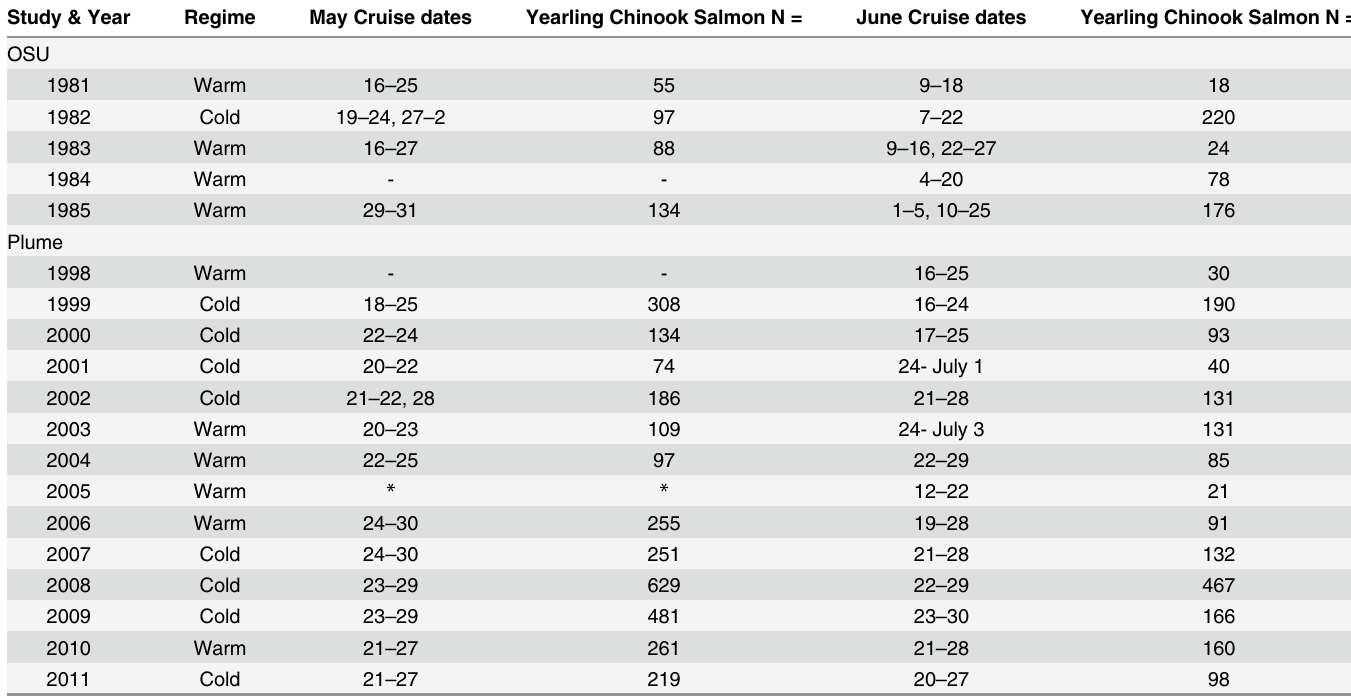
Table 1. Study period with regime condition, study dates, and sample size of yearling Chinook salmon collected in May and June.